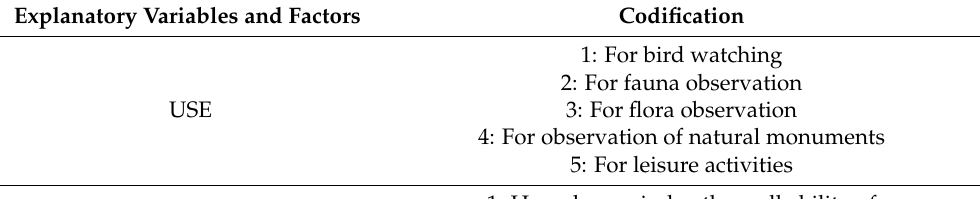
Table 2. List of explanatory variables and factors utilized for SEM